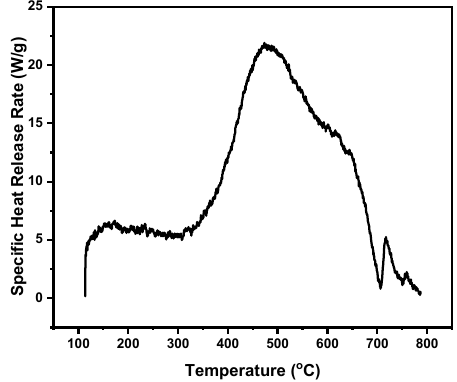
Figure 15. MCC curve of Laponite/CA-pdms-fu.